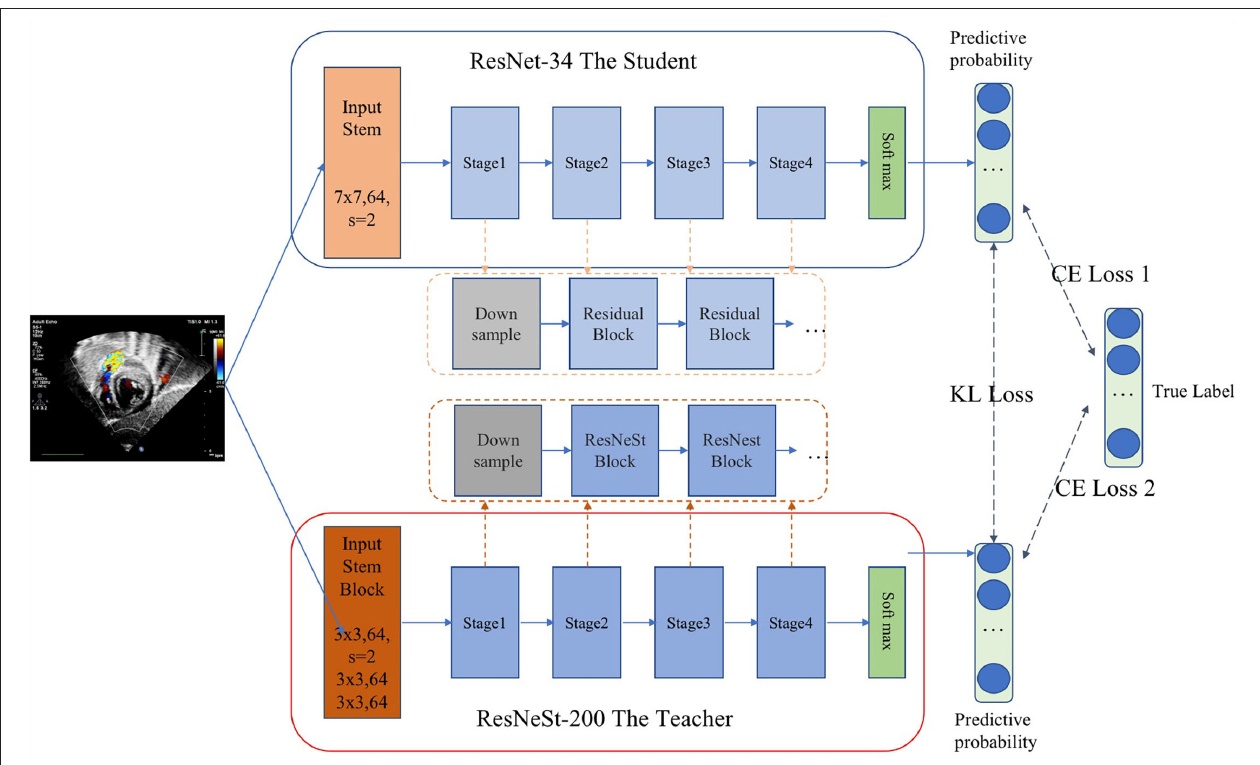
FIGURE 2 | The proposed network architecture for standard echocardiographic view